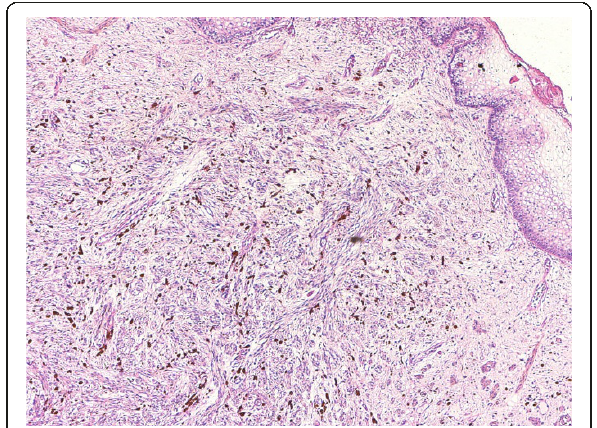
Figure 3 Photomicrograph of the vaginal mass . There is a subepithelial proliferation of spindle cells, accompanied by